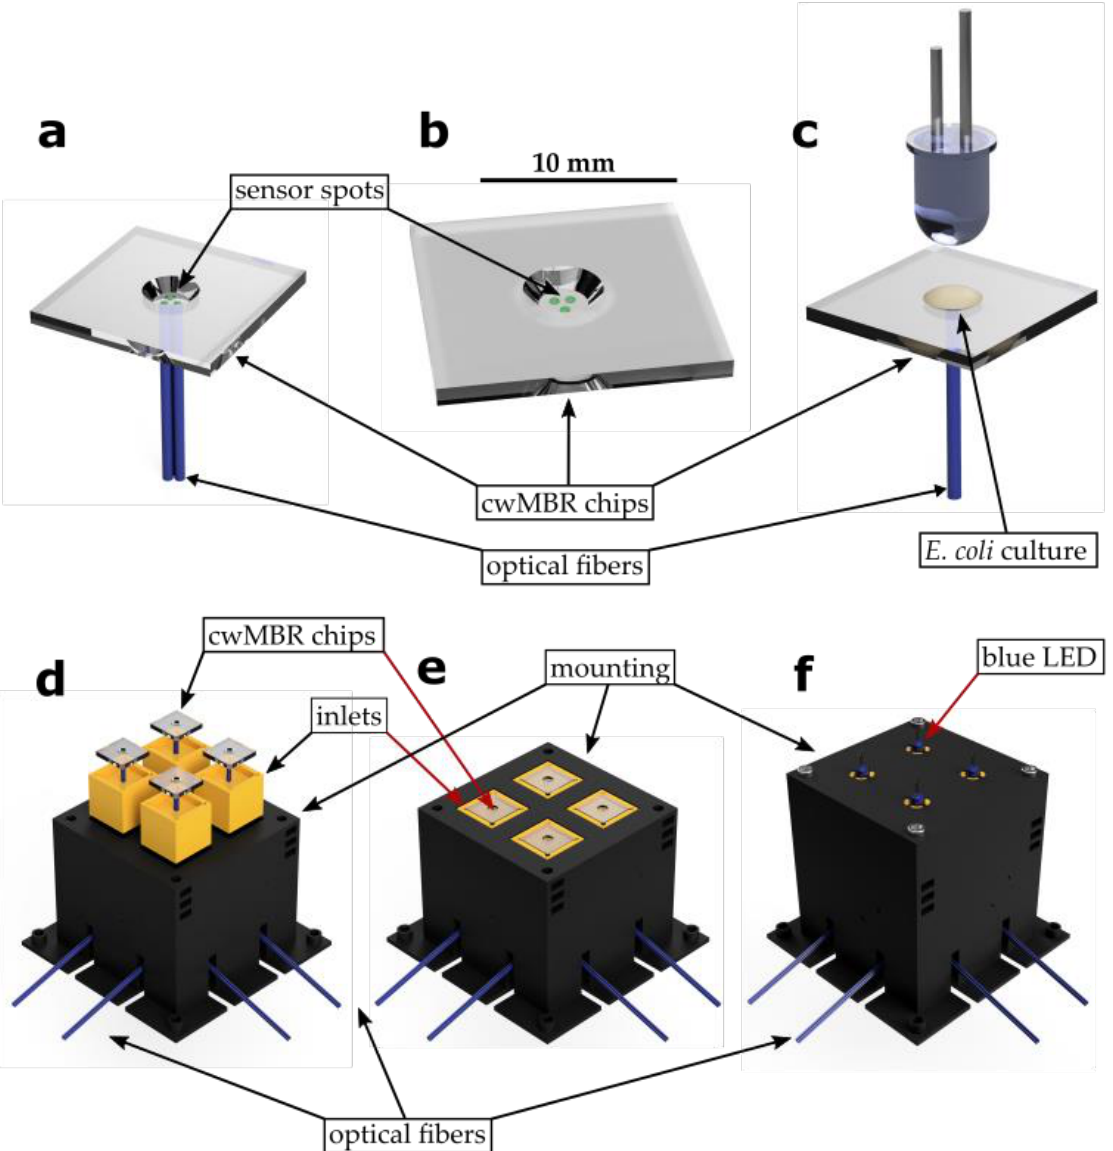
Figure 2. ( a ) Read-out of optical sensor spots in a cwMBR via optical fibers that are connected to a read-out device; ( b ) sensor spots on the bottom of the cwMBR; ( c ) absorption measurement in the cwMBR: a blue LED over the cwMBR is used as the light source. The unabsorbed light is measured by a spectrometer, which is connected to the cwMBR via optical fibers; ( d ) exploded view of the cwMBR mounting with cwMBRs in specific inlets for fixation of the cwMBR and optical fibers for sensor read-out; ( e ) assembled view of the cwMBR mounting; ( f ) cwMBR mounting with lid for minimal evaporation and integrated blue LEDs for absorbance measurement.